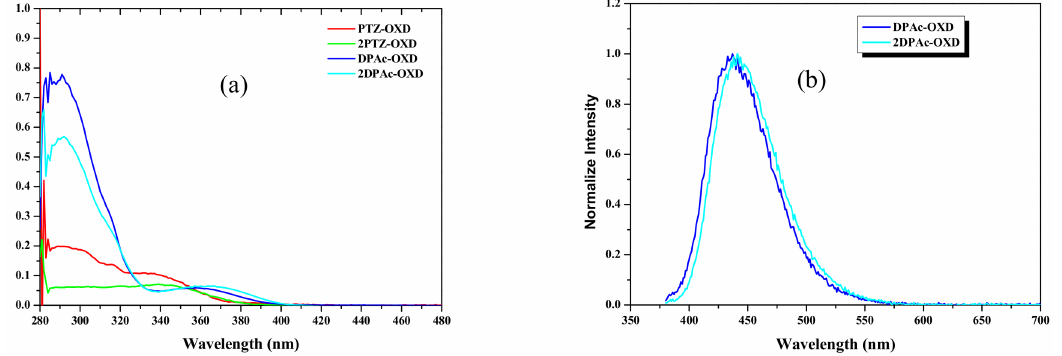
Figure 2. ( a ) UV-Vis absorption spectra ( b ) Photoluminescent spectra of fluorescent